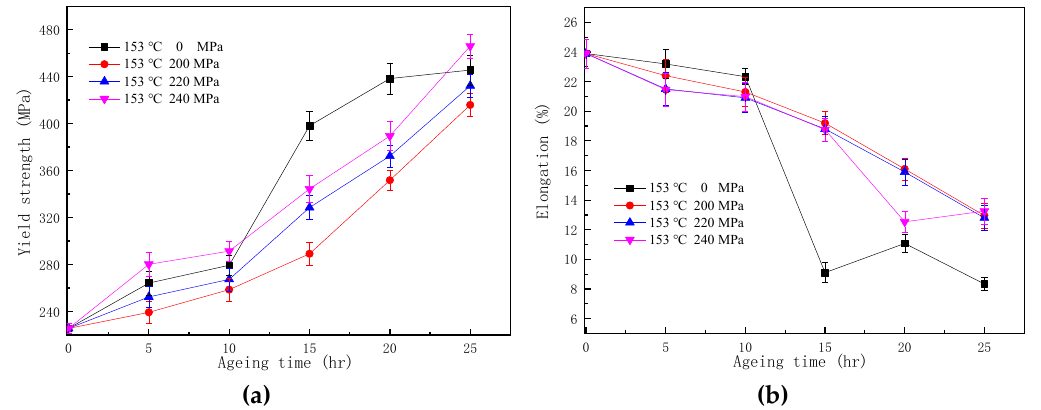
Figure 4. Engineering stress–strain curves of Al-Li-S4 alloy during the creep aging process at 155 °C and 240 MPa ( a ) and 16 h creep-aged samples under different applied stresses ( b ).